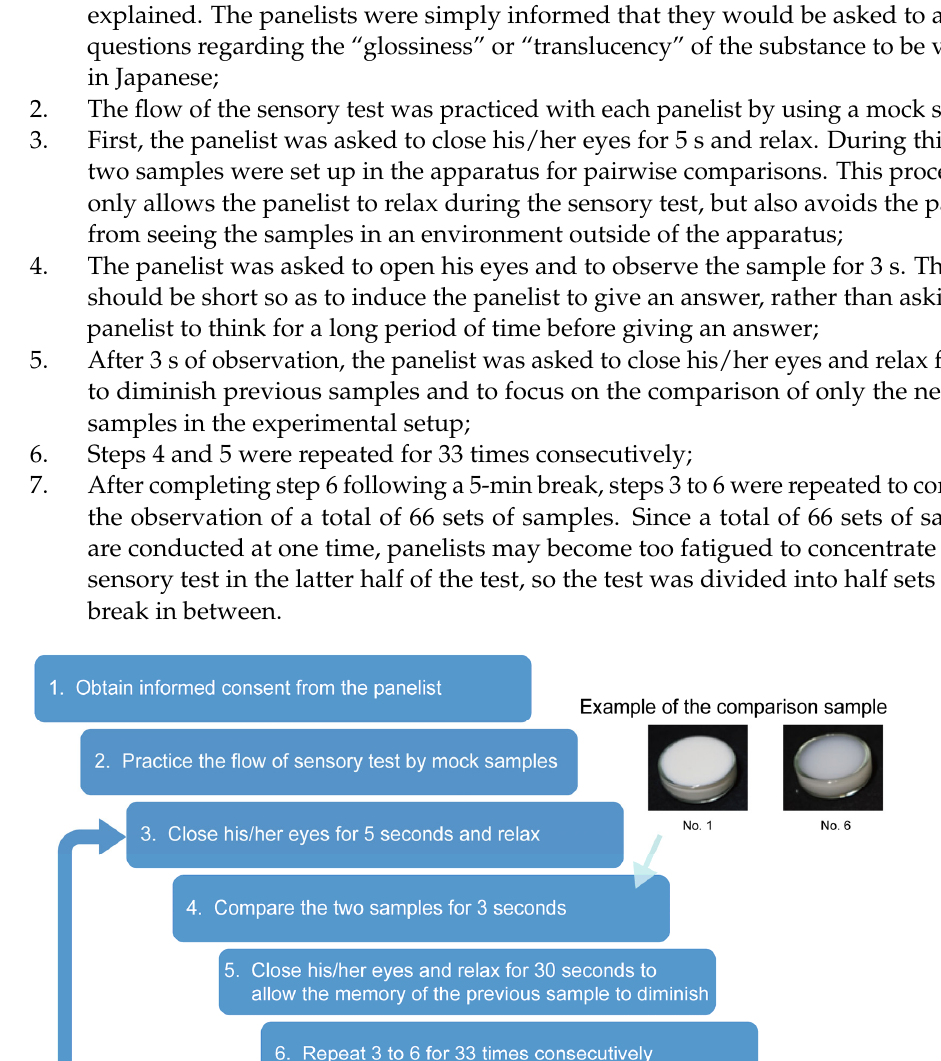
( b ) Figure 7. Scattering coefficients at different stirring speeds: ( a ) titanium dioxide sample (Nos. 1–5) and ( b ) zinc oxide sample (Nos. 6–10).